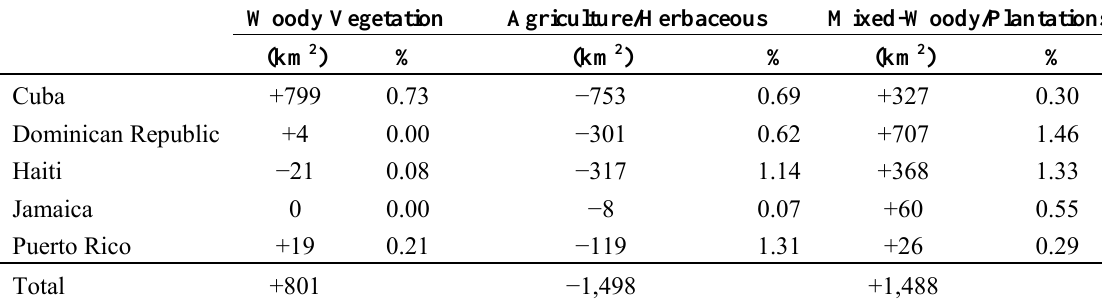
Table 3. Net changes in land-use and land-cover from 2001 to 2010, (in km 2 , and % of land in each country) only for municipalities that underwent significant change ( p ≤ 0.05